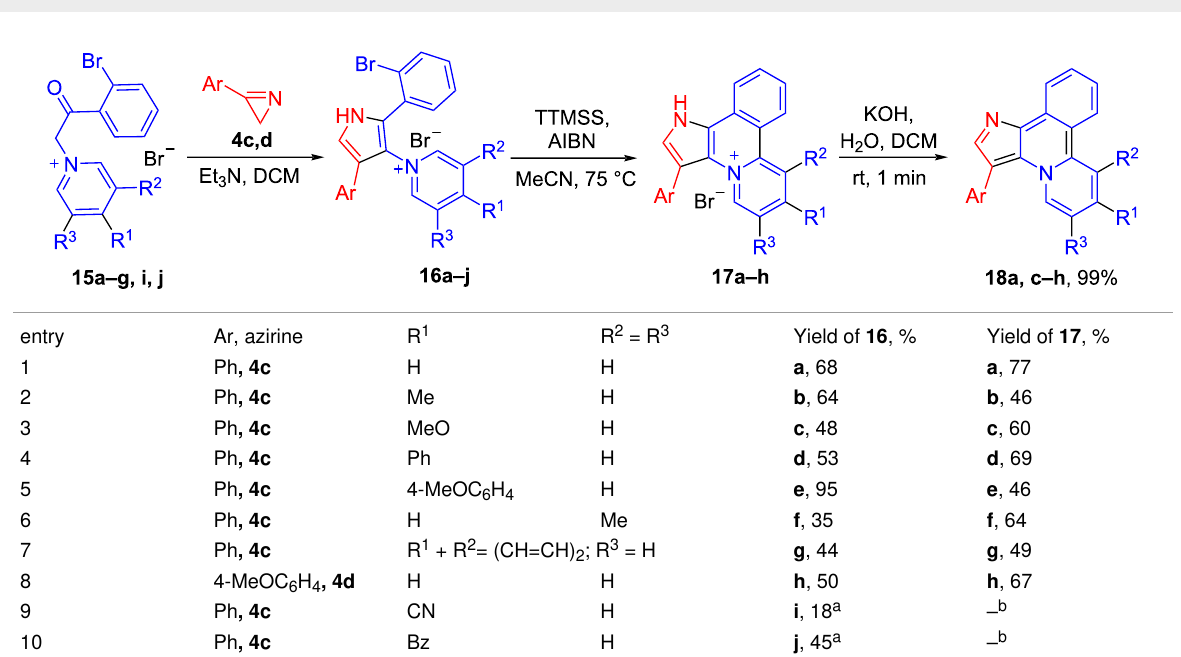
Table 3: Synthesis of compounds 16 – 18